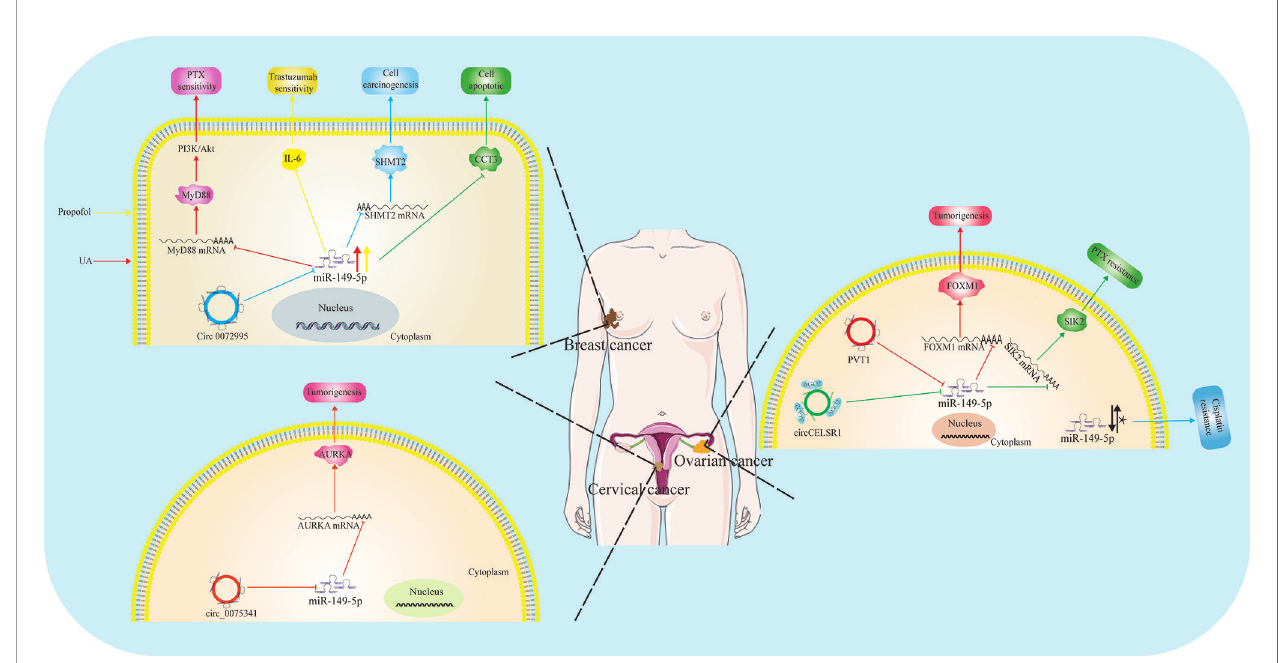
FIGURE 1 | Function and regulatory mechanism of miR-149-5p in reproductive system. MiR-149-5p plays an anticancer role in breast cancer and cervical cancer by targeting important genes. However, its role in ovarian cancer remains controversial (*). The expression of miR-149-5p is regulated by non-coding RNA, including circ_0072995, circ_0075341, circCELSR1 and